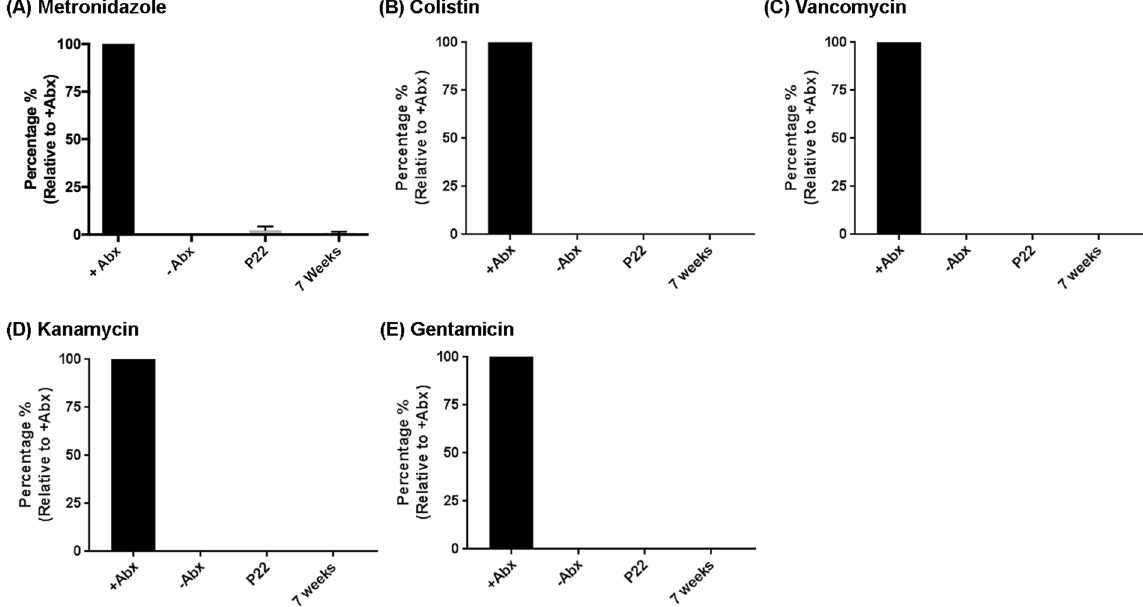
Figure 3. Metronidazole was present at very low levels in the brain parenchyma at both post-natal day (PND) 22 and 7 weeks of age. LC-MS was performed to investigate the ABX level in the brain. ( A ) Metronidazole in low level (less than 3%) was detected in brain homogenate extract while other ABX (colistin ( B ), vancomycin ( C ), kanamycin ( D ), gentamicin ( E )) were below the detectable range (LOD) in the brain homogenate extracts. N = 6/group, Data are mean ±